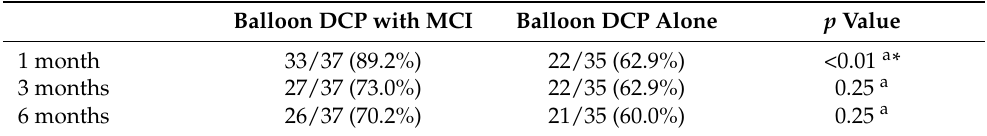
Table 2. Postoperative surgical success rate in patients in balloon DCP combined with pushed-type MCI group and balloon DCP alone group.